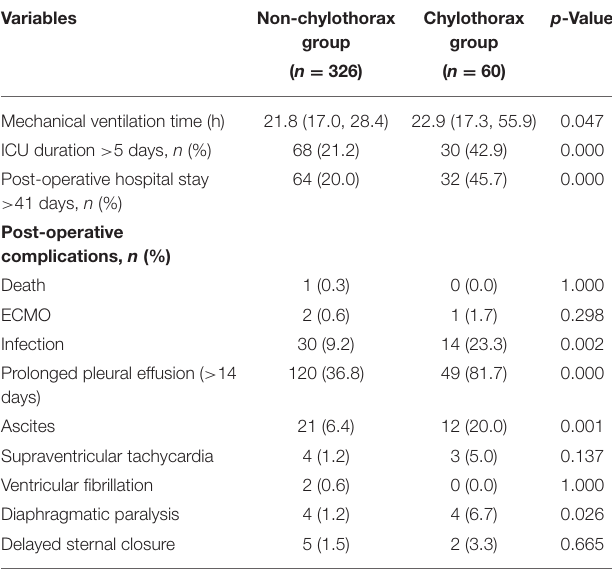
TABLE 3 | Early-term outcomes after TCPC operation between patients with and without chylothorax.